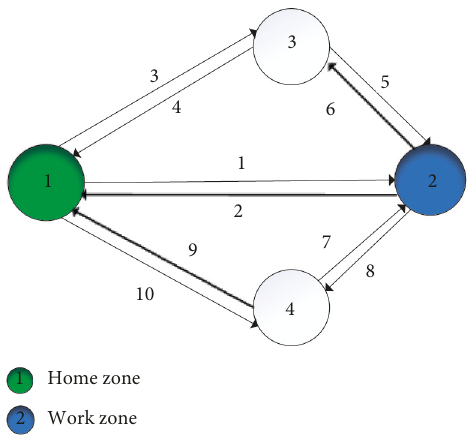
Figure 5: Four-node network example.